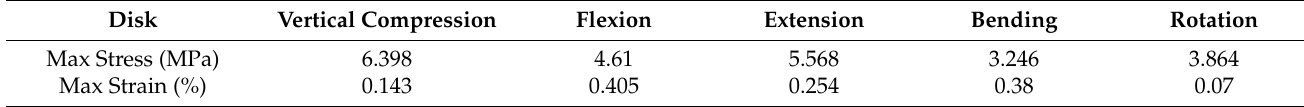
Table 19. The max stress and strain of the